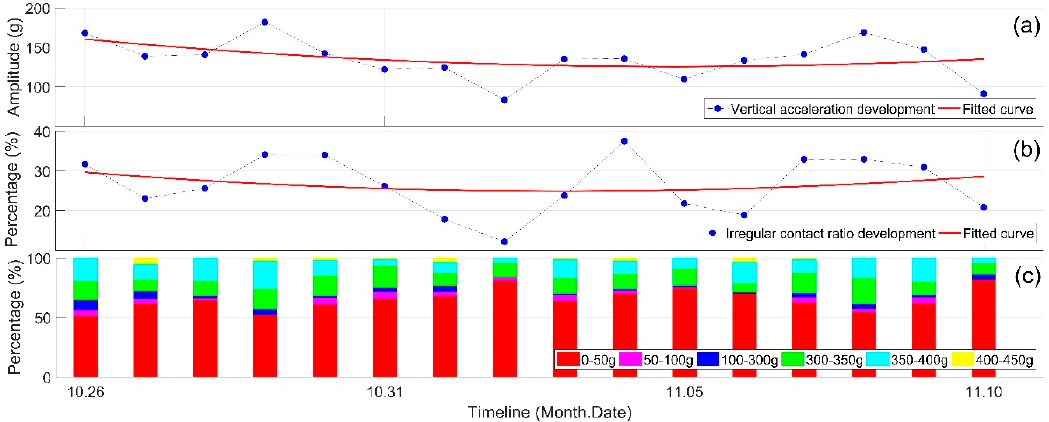
Figure 10. Development of the vertical acceleration responses in the monitored period. ( a ) Mean value of the vertical acceleration; ( b ) irregular contact ratio; ( c ) distribution of the acceleration responses for each day.